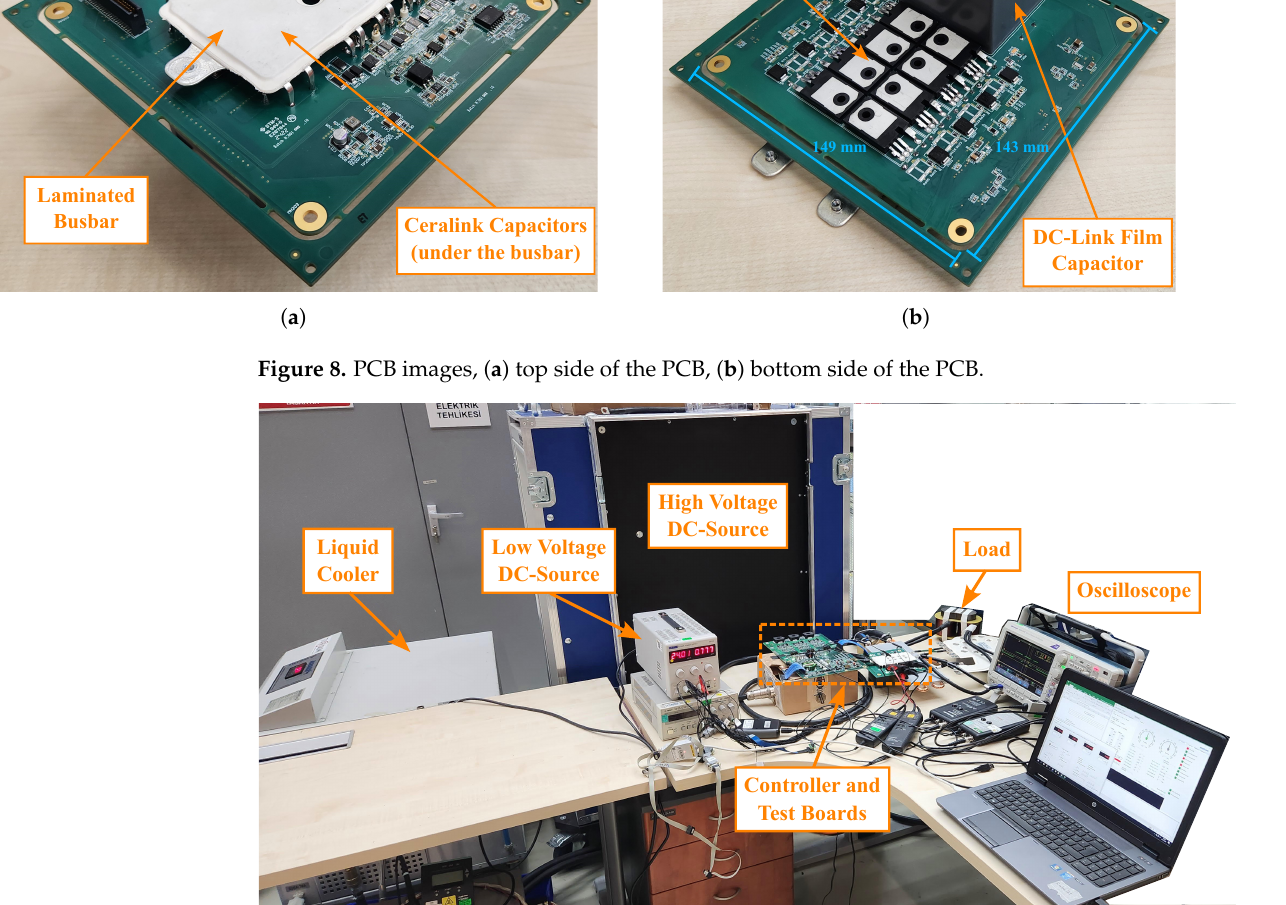
Figure 9. Experimental test